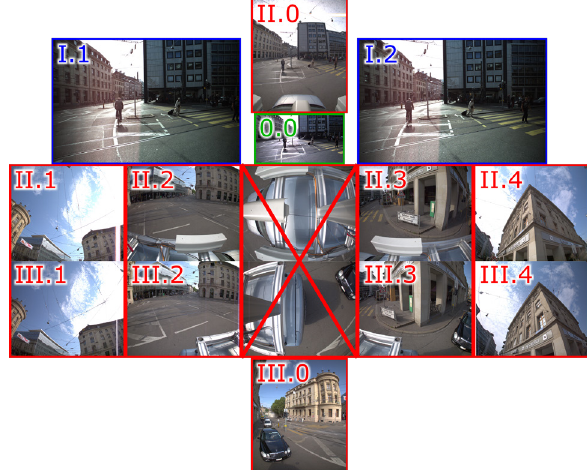
Figure 4. Images captured by all cameras at the same location